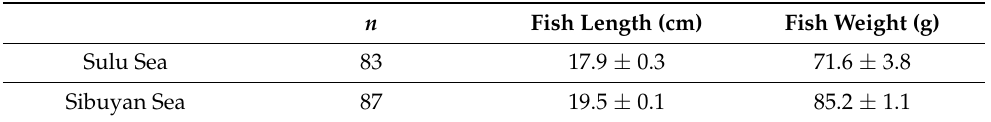
Table 2. Average total length and weight of fish collected from Sulu Sea and Sibuyan Sea, Philippines.